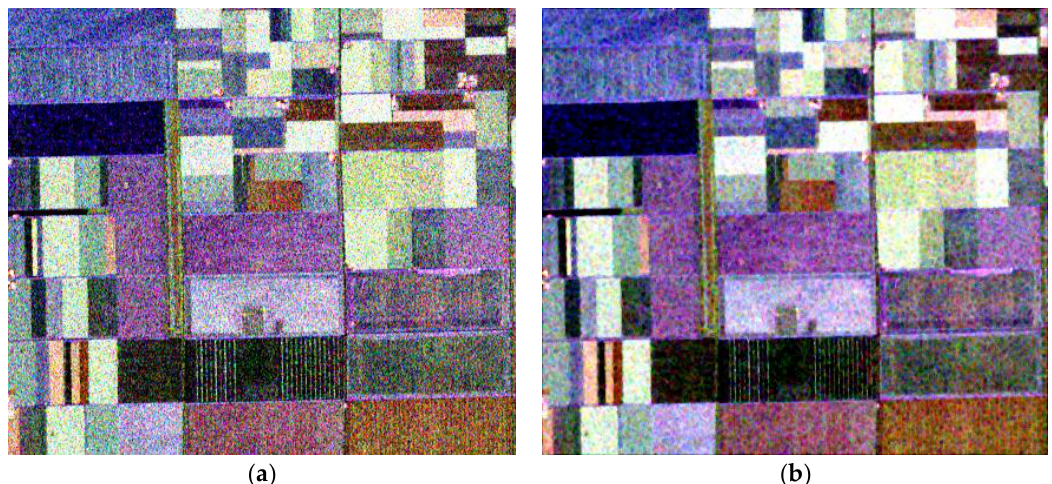
Figure 1. Pauli-RGB images of the Airborne Synthetic Aperture Radar (AirSAR) Polarimetric SAR (PolSAR) data: ( a ) Original image and ( b ) 3 × 3 refined Lee filtered image.